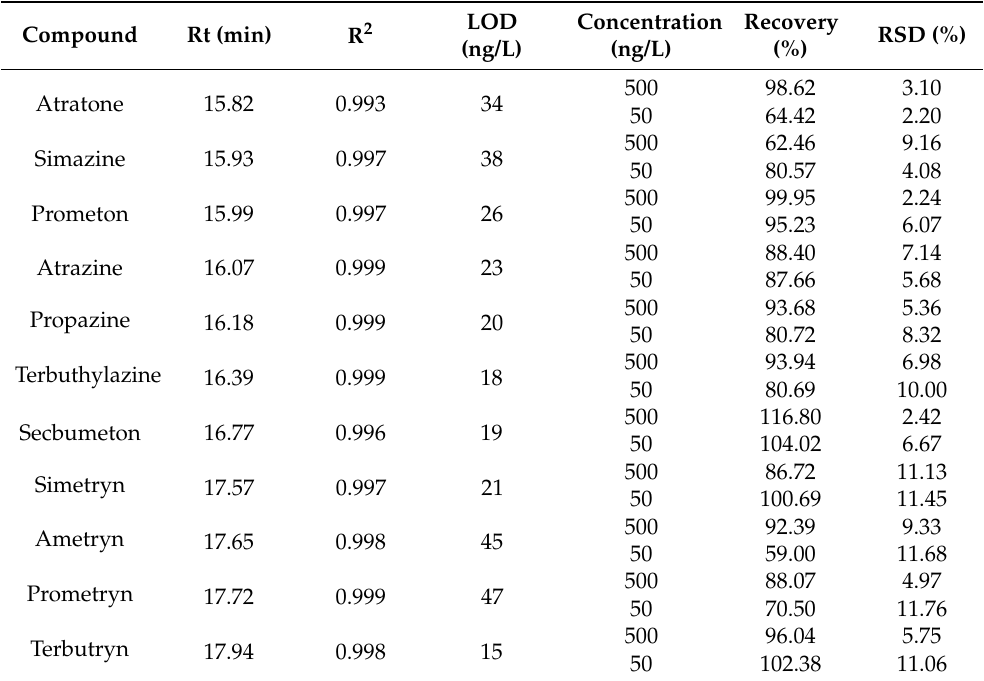
Table 1. Recoveries and RSDs of the selected pesticides.